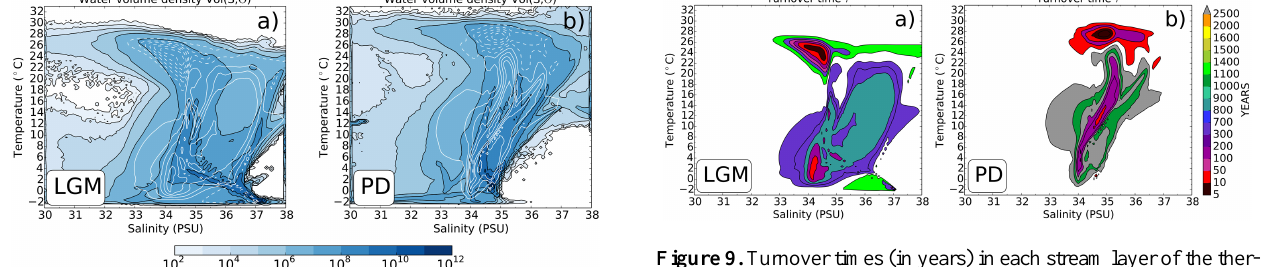
Figure 9. Turnover times (in years) in each stream layer of the ther- mohaline streamfunction computed for the (a) LGM simulation and (b) the PD